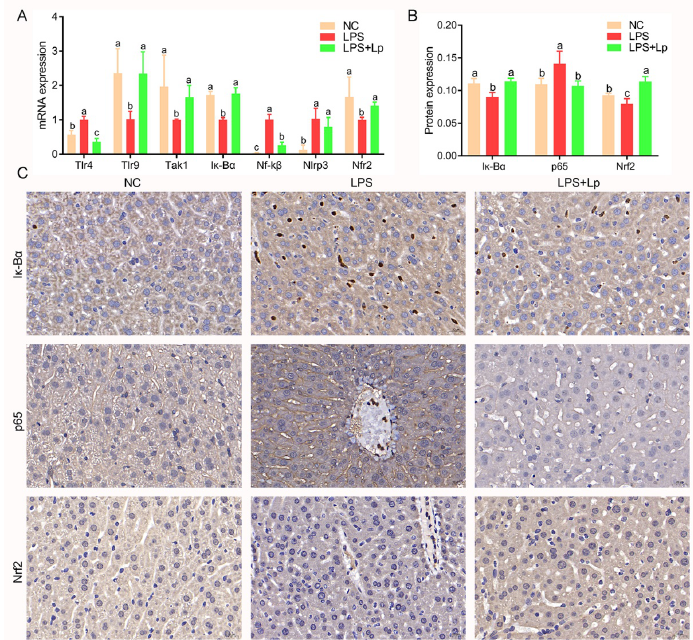
Figure 7. Effect of L. paracasei CCFM1223 on the expression of gene-related inflammation and oxidative stress in LPS-treated mice . mRNA expression for Tlr4, Tlr9, Tak1, Iκ - Bα, Nf - kβ, Nlrp3, and Nrf2 in liver ( A ). Immunohistochemical staining for Nf- kβ, p65, and Nrf2 in liver ( B ). The mean density of Nf- kβ, p65, and Nrf2 in liver ( C ). Values with different letters are significantly different ( p < 0.05).